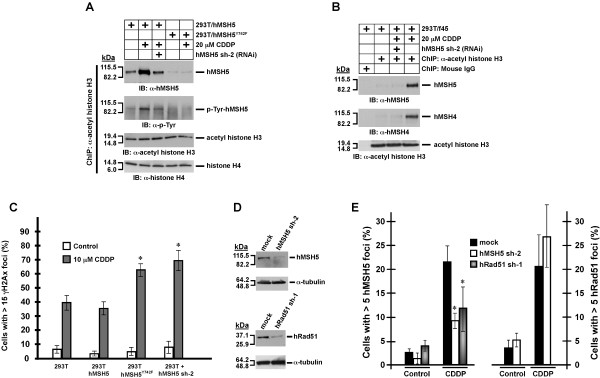
Analysis of cisplatin-induced hMSH5 association with chromatin and nuclear foci formation. (A) 293T/f-hMSH5 and 293T/f-hMSH5Y742F cells were treated with 20 μM cisplatin, and cross-linked bulk chromatin was immunoprecipitated by an α-acetyl-histone H3 antibody 5 hrs post-treatment. The levels of chromatin-associated hMSH5 and its levels of phosphorylation were analyzed by Western blotting. hMSH5 RNAi was used to knockdown hMSH5. Equal levels of acetyl-histone H3 and histone H4 were present in the immunoprecipitates. (B) Analysis of hMSH4 chromatin association following cisplatin treatment. Chromatin was prepared from 293T/f45 cells treated with cisplatin. The levels of chromatin-associated hMSH5 and hMSH4 were analyzed by Western blotting. hMSH5 RNAi was used to knockdown hMSH5. Mouse IgG was used as a negative control. kDa, molecular weight (Mr) in thousands. (C) Examination of γ-H2AX foci formation 24 hrs post cisplatin exposure. 293T, 293T/f-hMSH5, 293T/f-hMSH5Y742F, and 293T cells subjected to hMSH5 RNAi were used for this analysis. Cells possessing greater than 15 foci/nucleus were graphically displayed. (D) Immunoblotting analysis of the effectiveness of hRad51 or hMSH5 knockdown in 293T cells transfected with pmH1P-Bsd/hRad51 sh-1 or pmH1P-Bsd/hMSH5 sh-2. α-Tubulin was used as a loading control. kDa, molecular weight (Mr) in thousands. (E) Analysis of hMSH5 and hRad51 knockdown on cisplatin-induced hRad51 and hMSH5 nuclear foci formation. Cells were subjected to 10 μM cisplatin for 2 hrs and were analyzed for hMSH5 foci formation 6 hrs post cisplatin removal. Cells that possessed five or more nuclear foci for hMSH5 or hRad51 were scored. Error bars represent standard deviations of the means of three independent measurements. Statistically significant differences between knockdown and control cells were indicated with asterisks (p < 0.05, Student t-test).